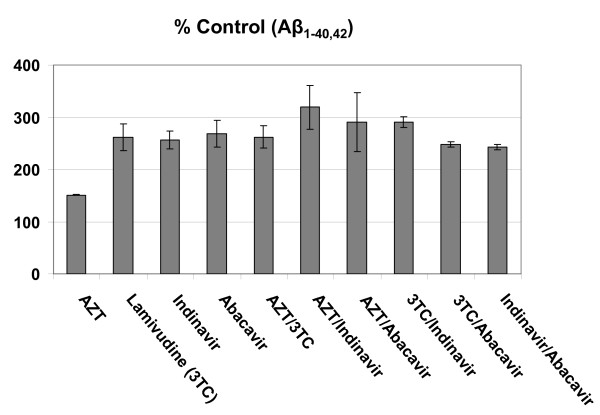
ART medications increase Aβ generation in cultured neuronal cells. Total Aβ 1-40,42 peptides were analyzed in conditioned media from SweAPP N2a cells by ELISA (n = 2 for each condition). Data are represented as a mean ± SEM percentage of Aβ 1-40,42 peptides secreted 18 hours after antiretroviral treatment relative to control (untreated). One-way ANOVA followed by post hoc comparison revealed significant increases in Aβ 1-40,42 production following 3TC/Indinavir, 3TC/Abacavir, and Indinavir/Abacavir treatements (concentration of 10 μM for each individual compound; p < 0.05).